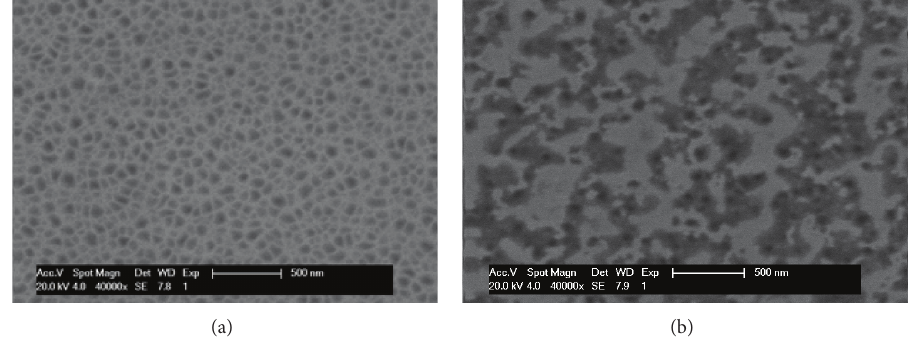
Figure 1: Surface structure investigated with SEM in the (100) oriented Ge single crystal, which exposed at 4 × 10 16 cm −2 Ga dose at an ion energy of 100 keV. (a) As-implanted sample. (b) Sample annealed at 800 ∘ C RTA in the flowing 𝐴𝑟 atmosphere.